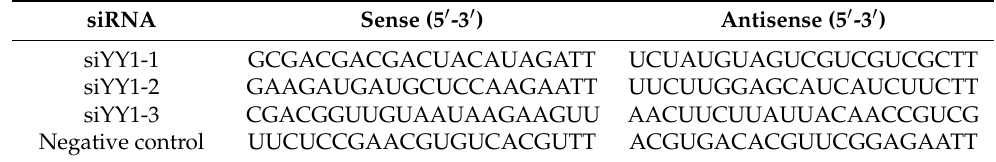
Table 1. Sequences of